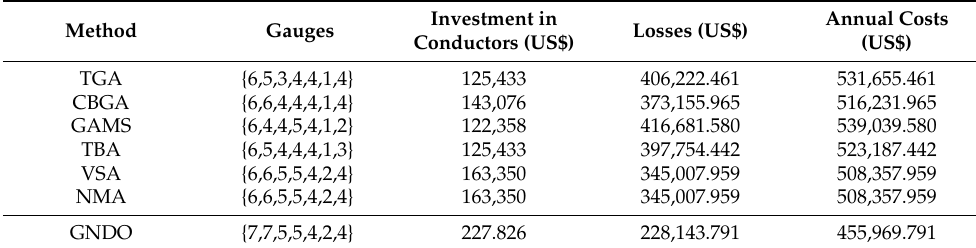
Table 9. Solutions obtained by different optimization